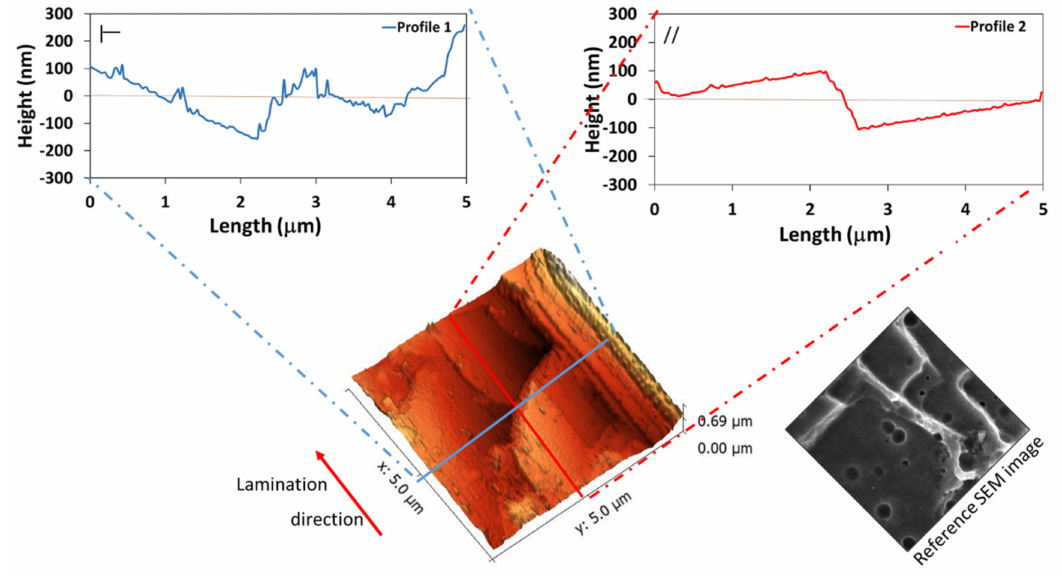
Figure 3. Three-dimensional AFM map and the two direction profiles of